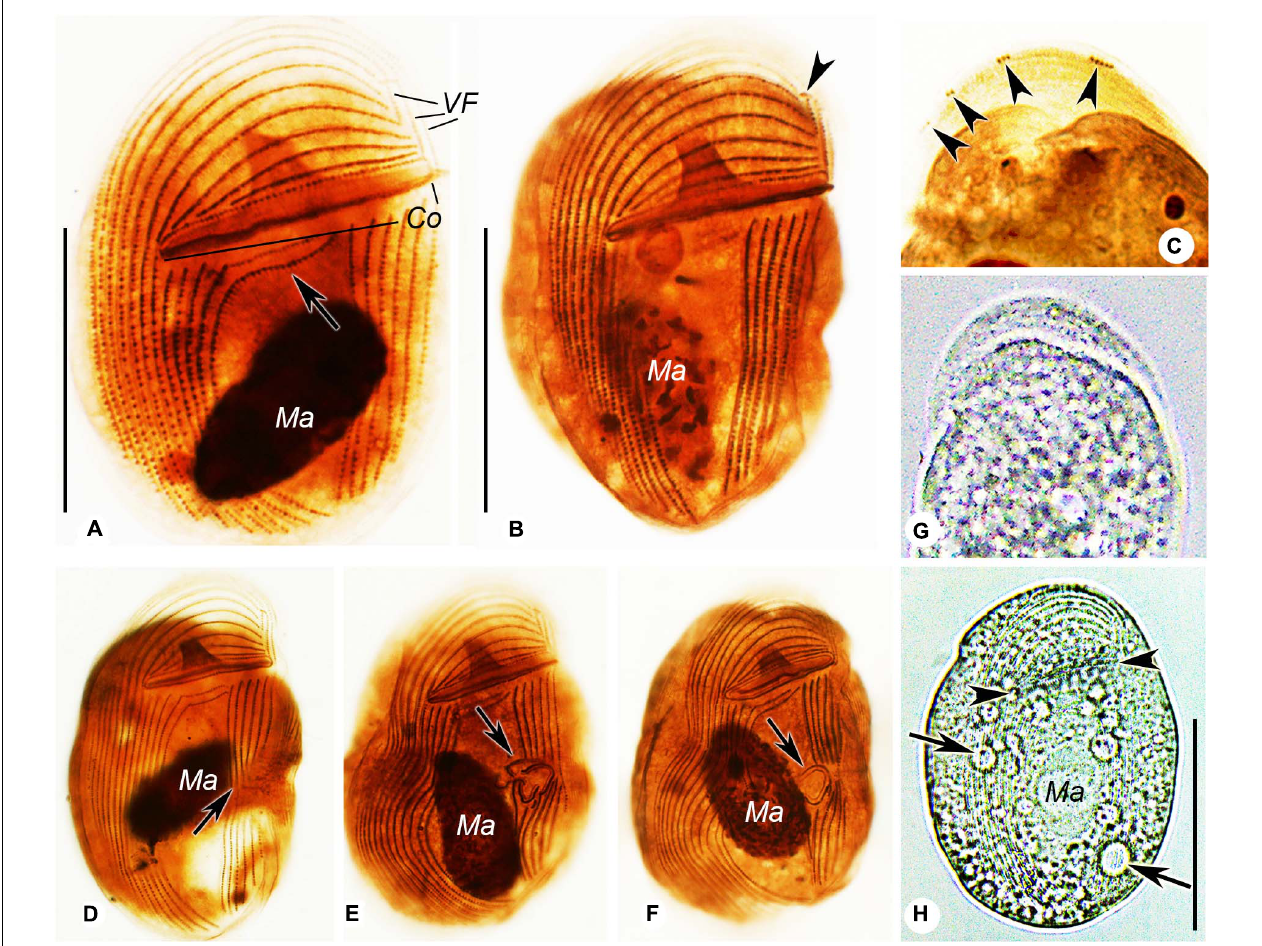
FIGURE 2 | Photomicrographs of Gastronauta paraloisi sp. n. after protargol-staining (A–F) and from life (G,H) . (A) Ventral view of general ciliature. Arrow shows the two curved postoral right kineties. (B) Ventral view of another individual. Arrowhead marks preoral kinety. (C) Dorsal view of anterior cell. Arrowheads point to terminal fragments. (D–F) Several stages of morphogenesis. (D) is an early stage, (E) is a middle stage, and (F) is a late stage. Arrows indicate the forming process of oral ciliature (stomatogenesis). (G) Dorsal view. (H) Ventral view of a slightly compressed individual. Arrows mark contractile vacuoles and arrowheads mark the oral slit. Abbreviations: Co, circumoral kinety; Ma, macronucleus; and VF, vertical fragments. Scale bars: 30 µ